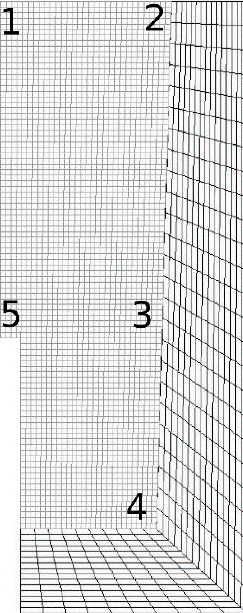
Figure 5. FE mesh of the specimen and mold used in the simulations. The location of the nodes, where the results were analyzed, are specified.